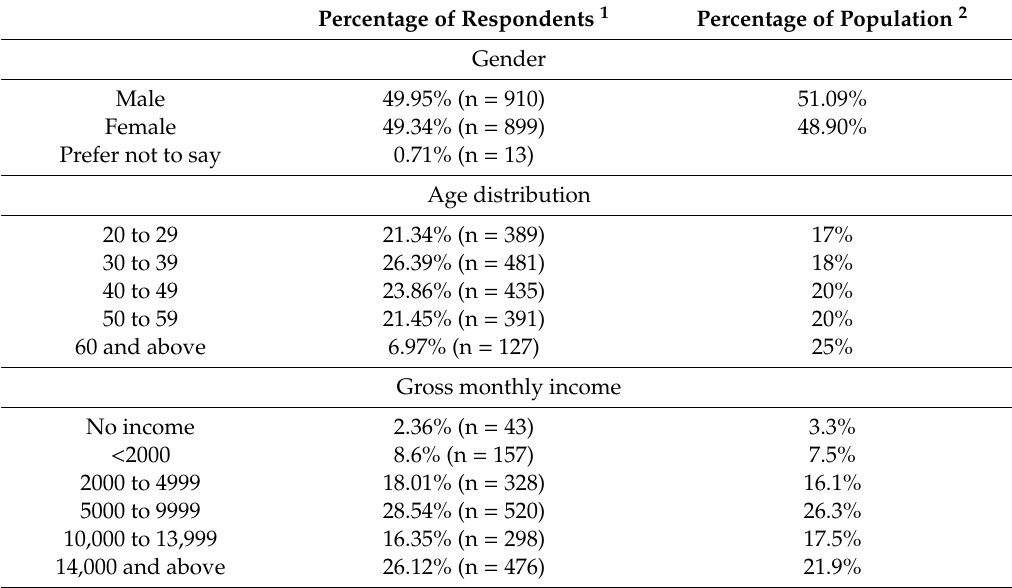
Table 1. Representative sample in terms of gender, age, and annual income. Comparison between the sample and the Singapore